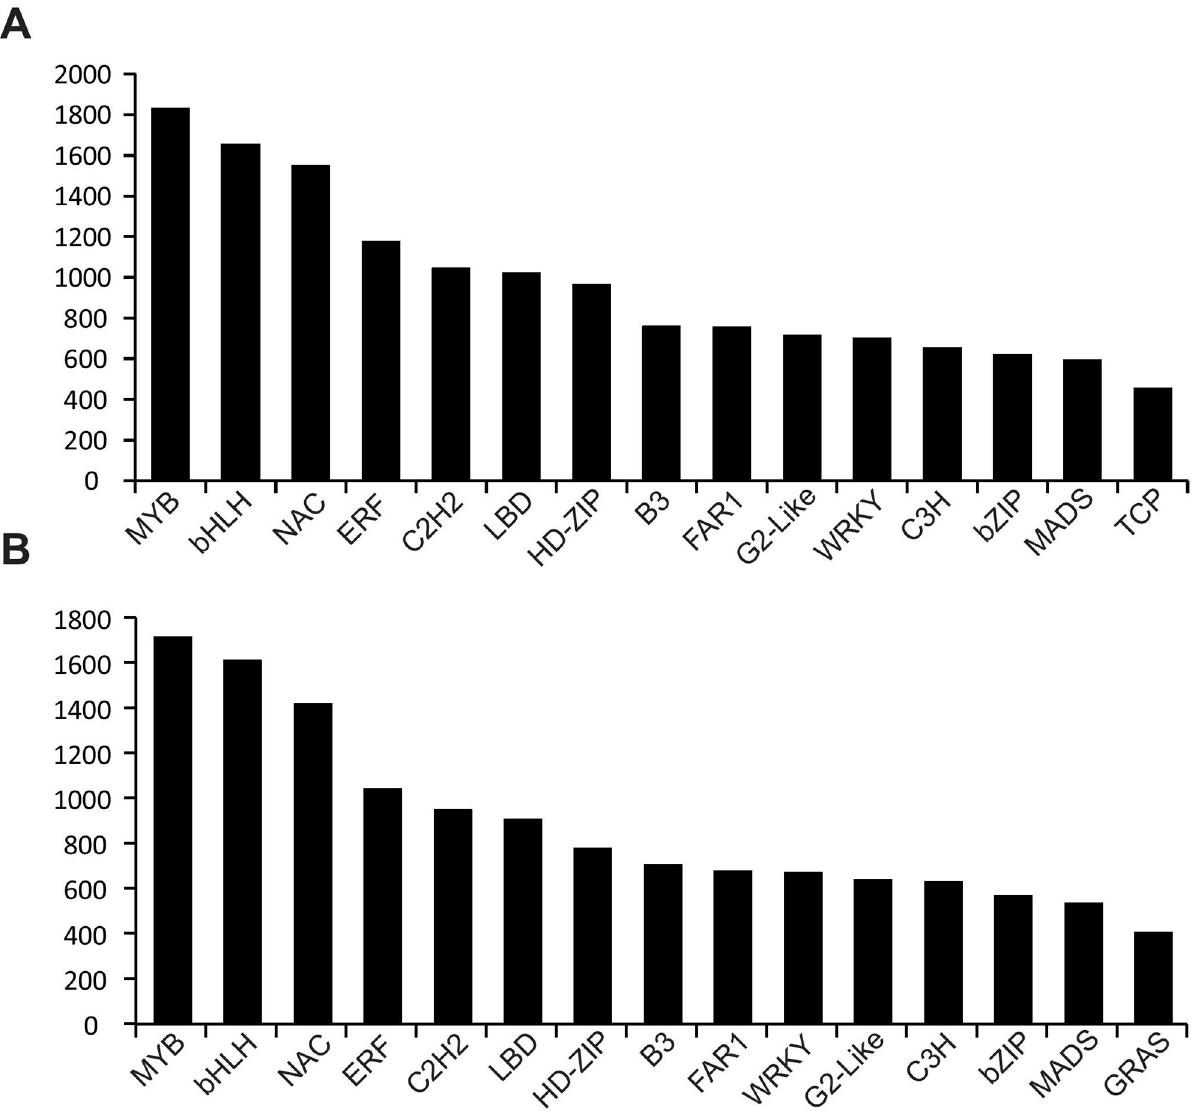
Fig 5. Transcription factor distribution in assembled transcriptome of A. drought sensitive (1627) and B. tolerant (1656) onion genotypes under drought stress.